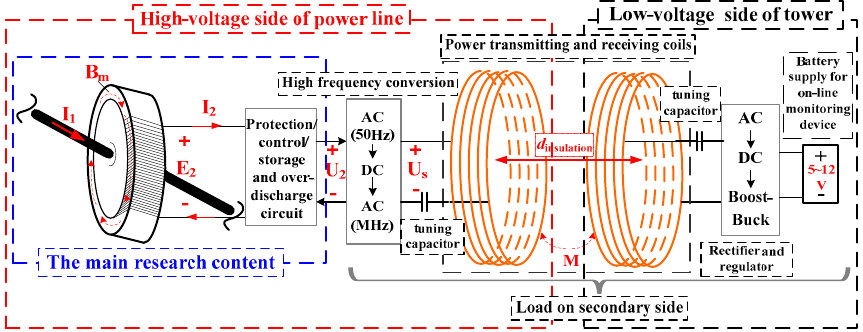
Figure 1. Structure of a wireless power supply system for high voltage power lines (HVPLs). AC, alternating current; DC, direct current.